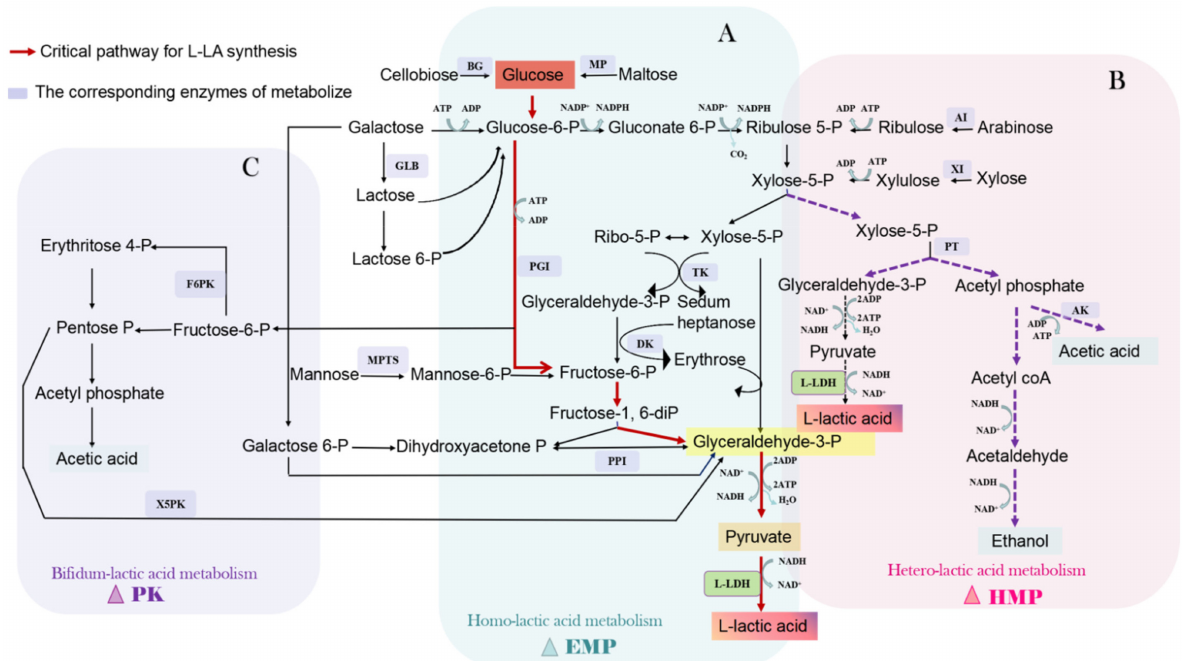
Figure 1. Biosynthesis pathway of L-LA. BG, β -1,4-glucanase; MP, maltose phosphorylase; GLB, β -galactoenzyme; AI, arabinose isomerase; XI, xylose isomerase; TK, transketolase; DK, dihydroxy- acetone kinase; PT, phosphotransferase; AK, acetate kinase; PPI, propanose phosphate isomerase; PGI, phosphoglucose isomerase; MPTS, mannose phosphotransferase system; F6PK, F6P ketolyase; X5PK, xylukelose 5-phosphate